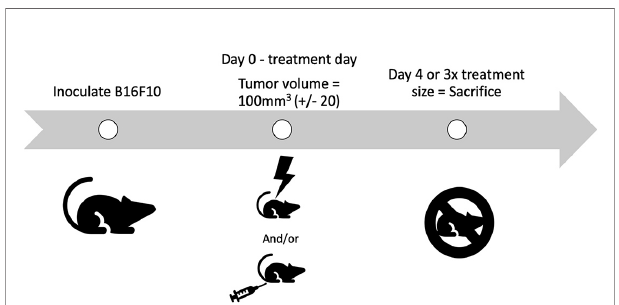
FIGURE 2 | Schematic of the study design. B16-F10 cells are inoculated intradermally, with animals placed on study on day 0, when their tumors reach treatment size. Animals receive their treatment on day 0, either PBS, radiation, Cowpea mosaic virus (CPMV), or the combination. Two cohorts of animals are used for each treatment. One cohort is removed on day 4, for molecular and cellular investigation (n = 4 – 6), and the other cohort is removed once the tumors reach 3x the volume when treated (n = 4